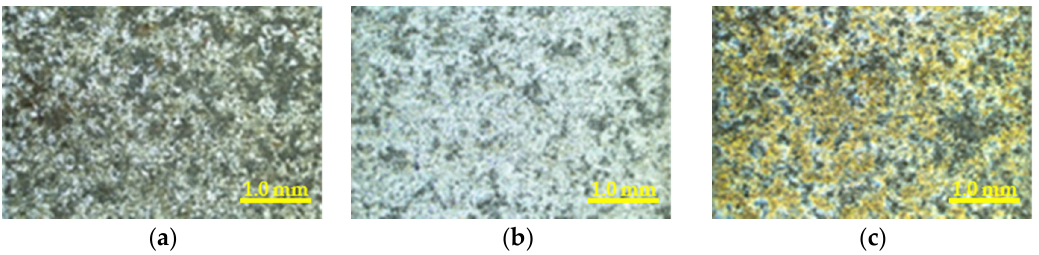
Figure 4. Photos of three kinds of cleaning performance sample. ( a ) Photo of the insufficient cleaning performance; ( b ) photo of the qualified cleaning performance; ( c ) photo of the over cleaning performance.